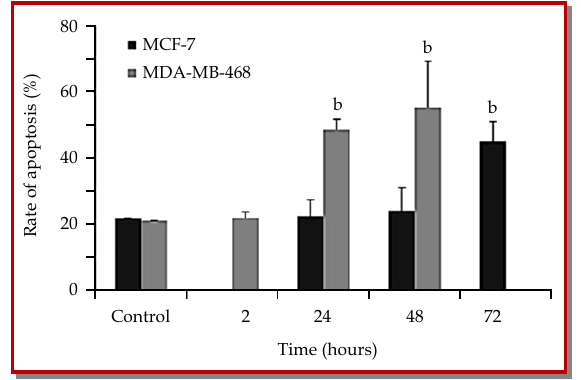
Figure 3: Rate of apoptosis in MCF-7 cells after 24, 48 and 72 hours treatment with 100 μ g/mL A. repens extract and in MDA-MB-468 cells after 3, 24 and 48 treatment with 35 μ g/mL A. croptilon repens extract